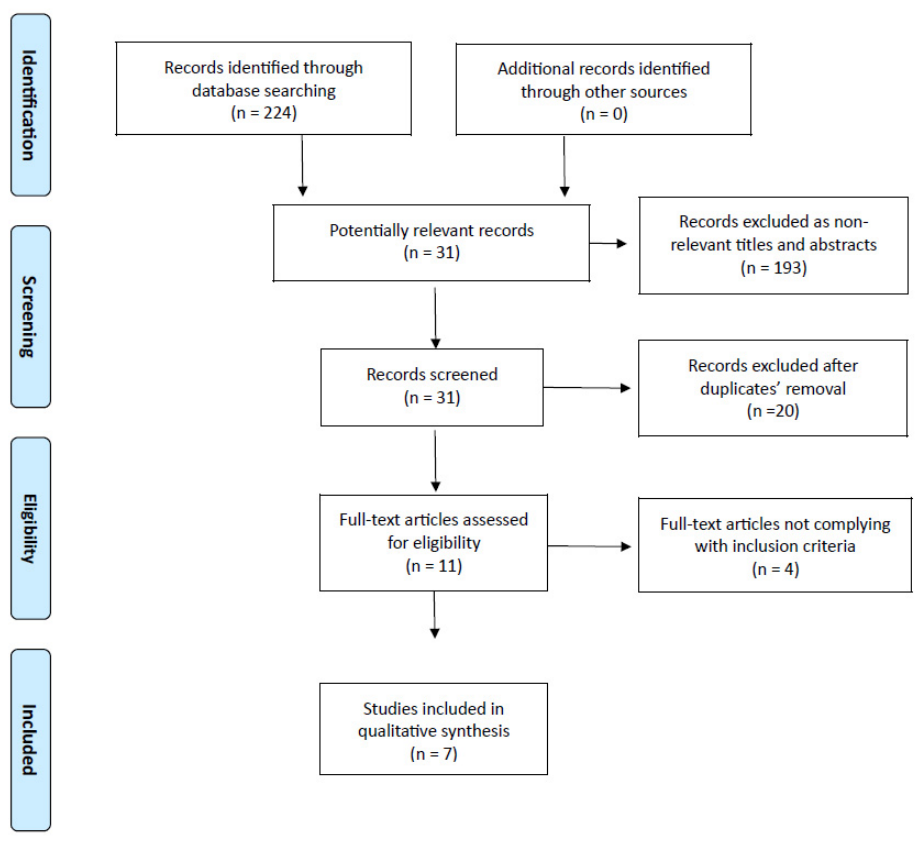
Figure 1. PRISMA flow chart of literature search.